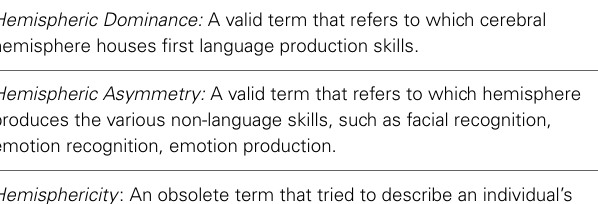
hemisphere houses first language production